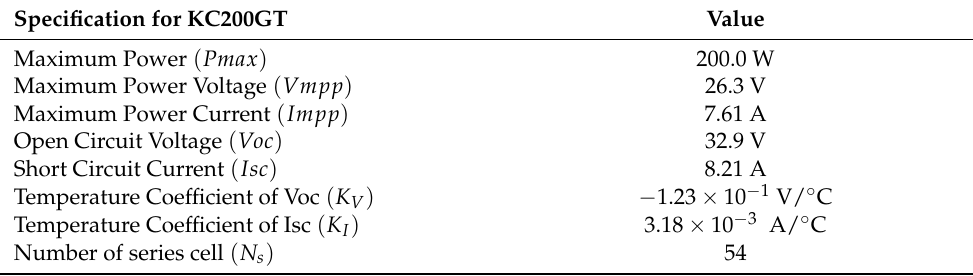
Table 2. Electrical Performance at Standard Test Conditions (STC).